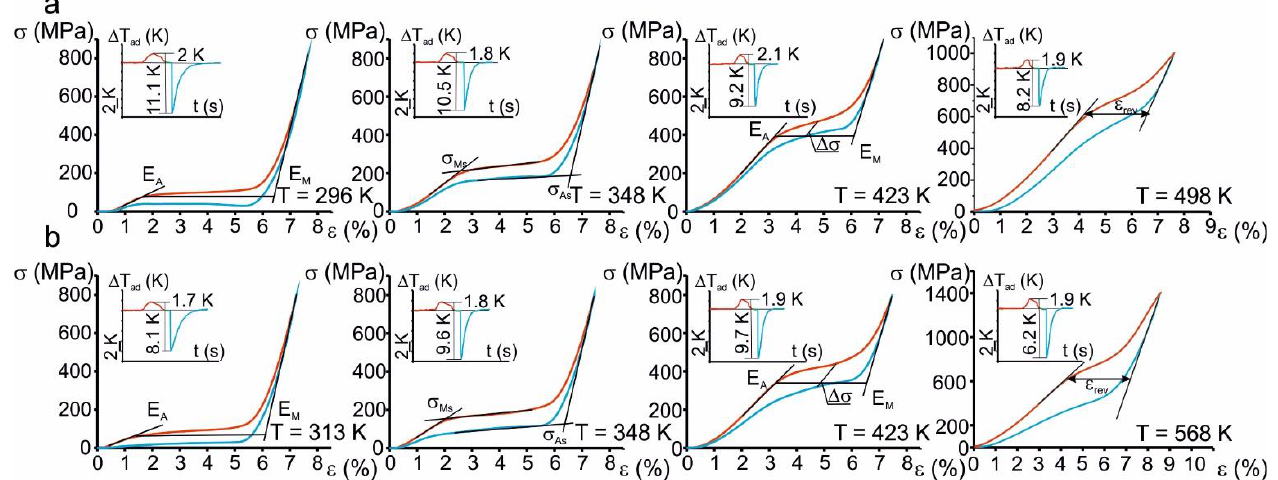
Figure 4. SE curves and corresponding thermograms at different test temperatures for [001]-oriented Ni 54 Fe 19 Ga 27 single crystals aged at 773 K for 1 h ( a ) and aged at 1373 K for 0.5 h ( b ).